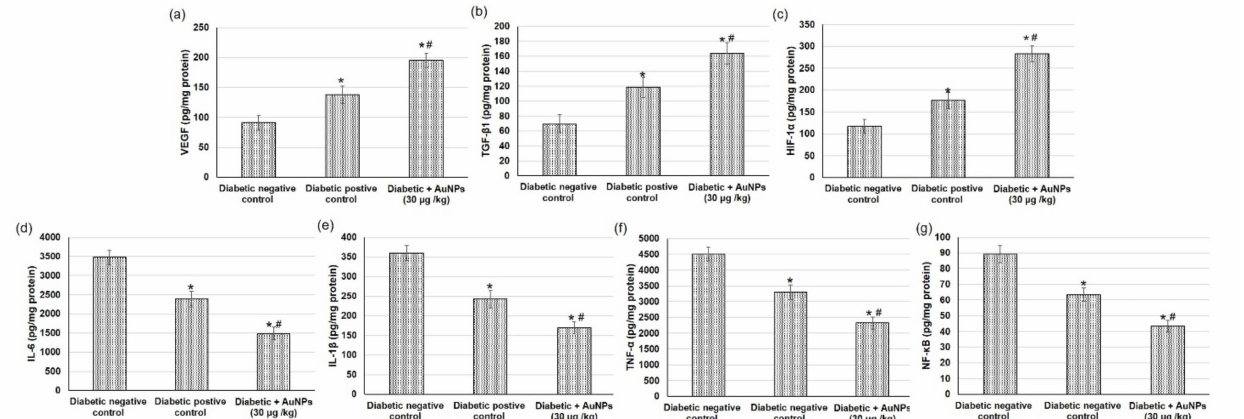
Figure 9. Effect of topical application of AuNPs in excision wound model on angiogenesis-related factors including ( a ) VEGF, ( b ) TGF- β 1, and ( c ) HIF-1 α and on inflammatory mediators including ( d ) IL-6, ( e ) IL-1 β , ( f ) TNF- and ( g ) NF- κ B in diabetic animals. All values were expressed as mean ± SD ( n = 6). * indicates statistically significant from the diabetic negative control group ( p < 0.05), # indicates statistically significant from diabetic positive control group using one-way ANOVA followed by Tukey’s test as a post hoc